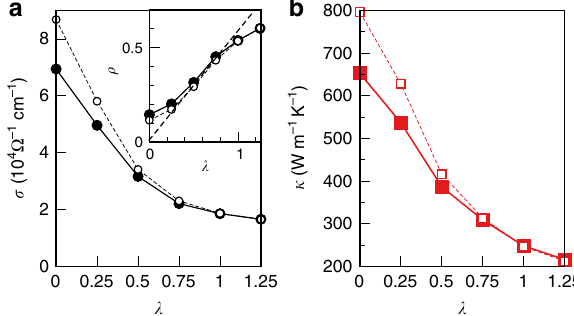
Fig. 3 Total conductivity vs. the degree of lattice distortion. The electrical ( a ) and thermal ( b ) conductivities are displayed as a function of the distortion level λ varying from 0 (perfect lattice) to 1 (full distortion), and beyond. The solid lines (full symbols) are calculated with full self-consistent density- functional theory + dynamical mean- fi eld theory (DFT + DMFT) method at the corresponding distortion levels; dashed lines (empty symbols) are obtained using the averaged self-energy 〈 Σ 〉 at full distortion λ = 1. The inset in ( a ) shows the corresponding resisitivity ρ and indicates the onset of saturation at large λ with deviation from linearity (straight dashed